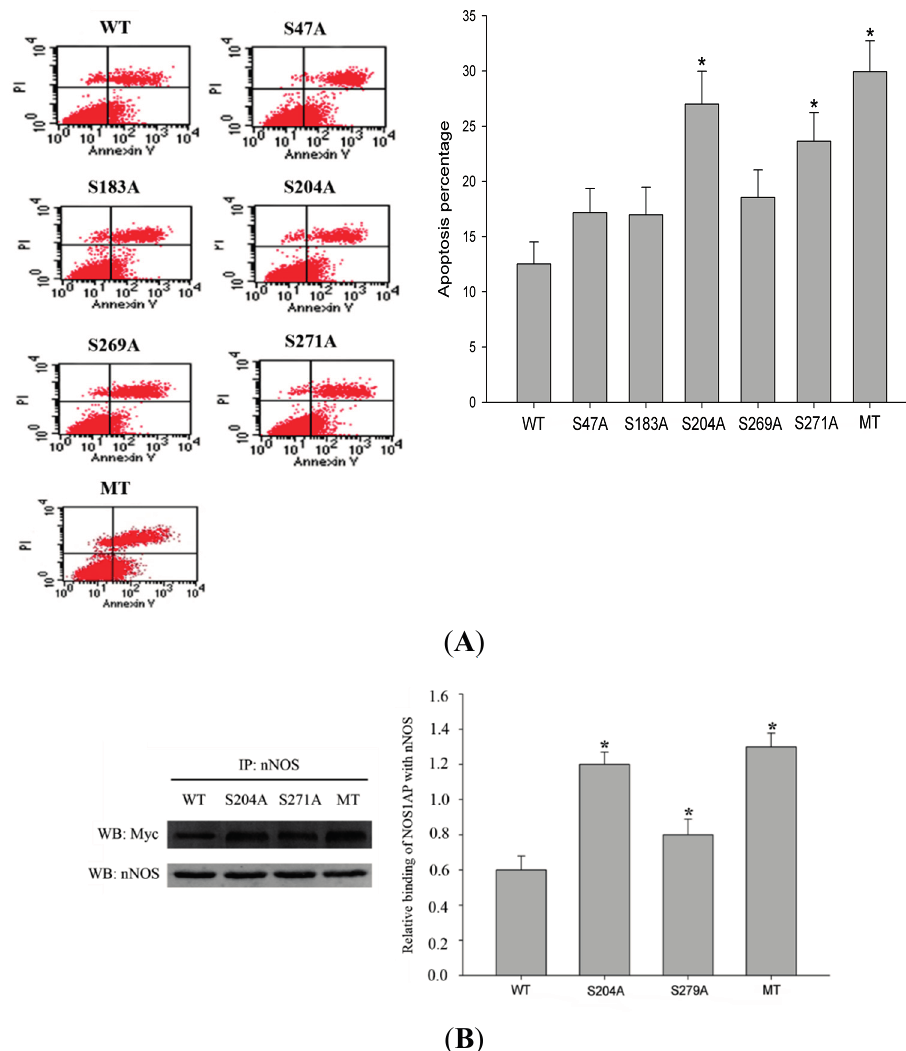
Figure 5. Glycosylation of NOS1AP exerts protective effects through affecting its interaction with nNOS. ( A ) PC12 cells were transfected with WT NOS1AP or O -GlcNAc sites mutated NOS1AP. Cells were stimulated with glutamate at concentration of 300 μ M/L for 12 h before staining with FITC annexin V and propidium. Apoptosis was then evaluated by flow cytometry; ( B ) PC12 cells were transfected with Myc-tagged WT NOS1AP, S204A, S271A and all O -GlcNAc sites mutated NOS1AP. The same amount of nNOS was immunoprecipitated and immunoblotted for Myc. ( * p < 0.05, significantly distinct from the WT NOS1AP transfected